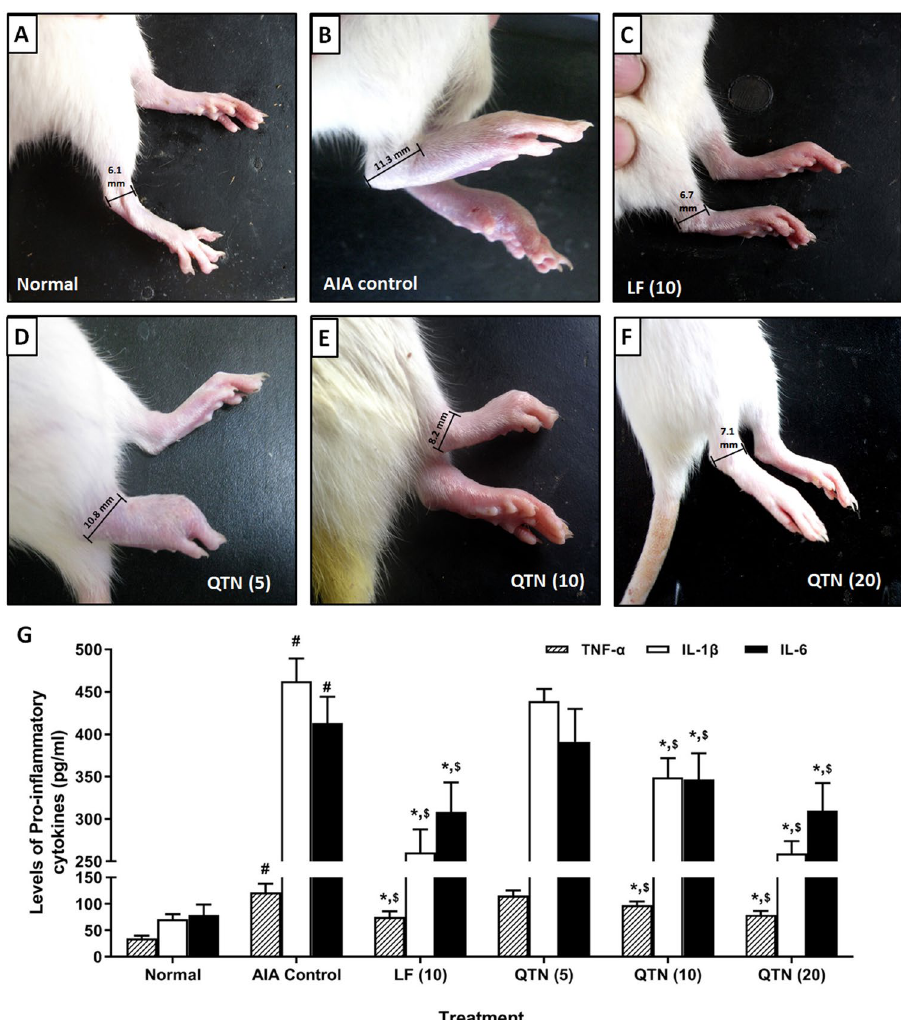
Figure 2. Effects of QTN on severity of ankle inflammation in rats (A-F). Representative images of paw from ( A ) normal rats, ( B ) AIA control rats with higher degree of inflammation, ( C ) Leflunomide (10 mg/kg) treated rats with reduced ankle inflammation, (D) QTN (5 mg/kg) treated rats with severe inflammation, ( E ) QTN (10 mg/kg) and ( F ) QTN (20 mg/kg) treated rats with reduced ankle inflammation. Effects of QTN on FCA- induced alterations in pro-inflammatory cytokines levels in synovial tissues (G). Values in parentheses indicate a dose in mg/kg (n = 6). Data was analyzed by one-way ANOVA followed by Tukey’s multiple comparisons test. For comparison with AIA-control group: * p < 0.05, comparison with normal group: # p < 0.05 and comparison with one another: $ p < 0.05. AIA adjuvant-induced arthritis, LF leflunomide, QTN 3,5,7,3 ′ ,4 ′ -pentahydroxy flavone, TNF‑α tumor necrosis factor-alpha, ILs